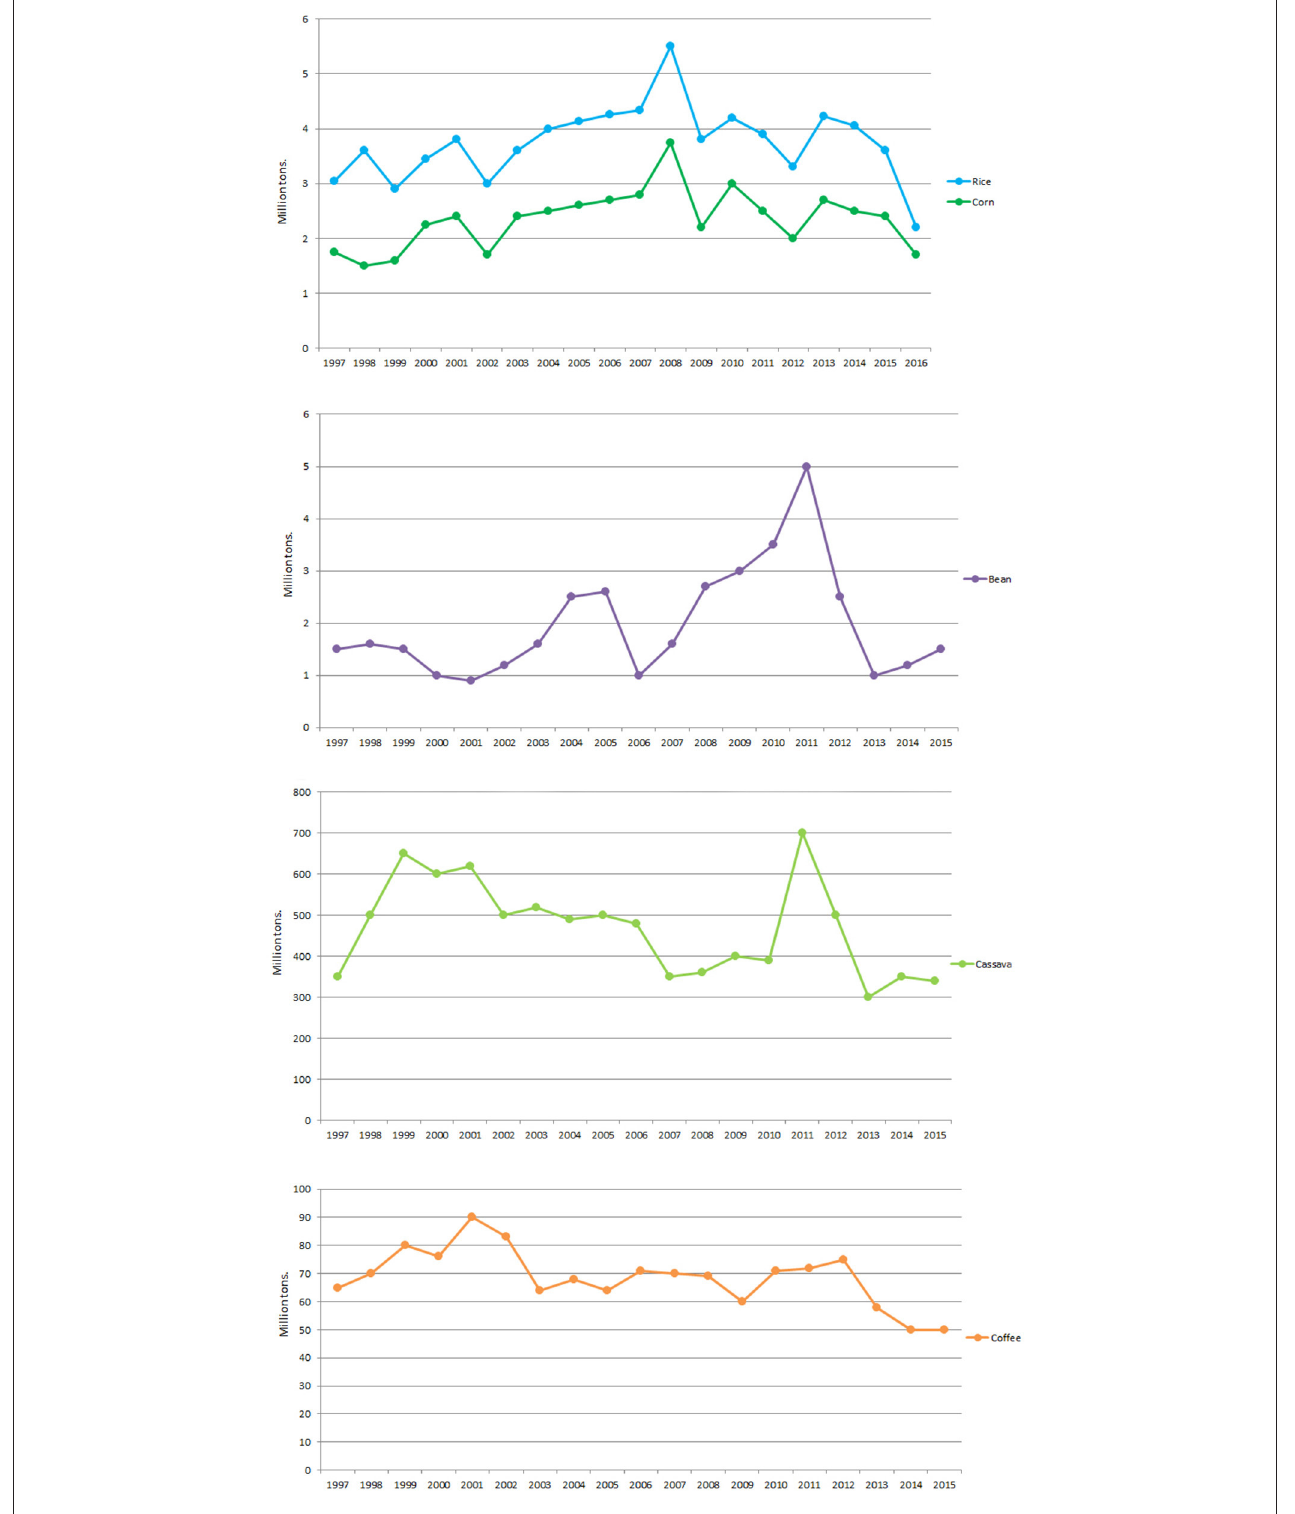
FIGURE 1 | Production of principal crops in Venezuela in the period 1997–2015. Source: FEDEAGRO (Confederación de Productores Agropecuarios de Venezuela), 2017.